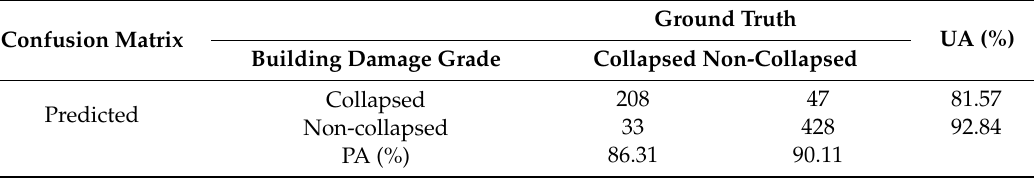
Table 2. Results of fine-tuned pretrained VGGNet model with dataset